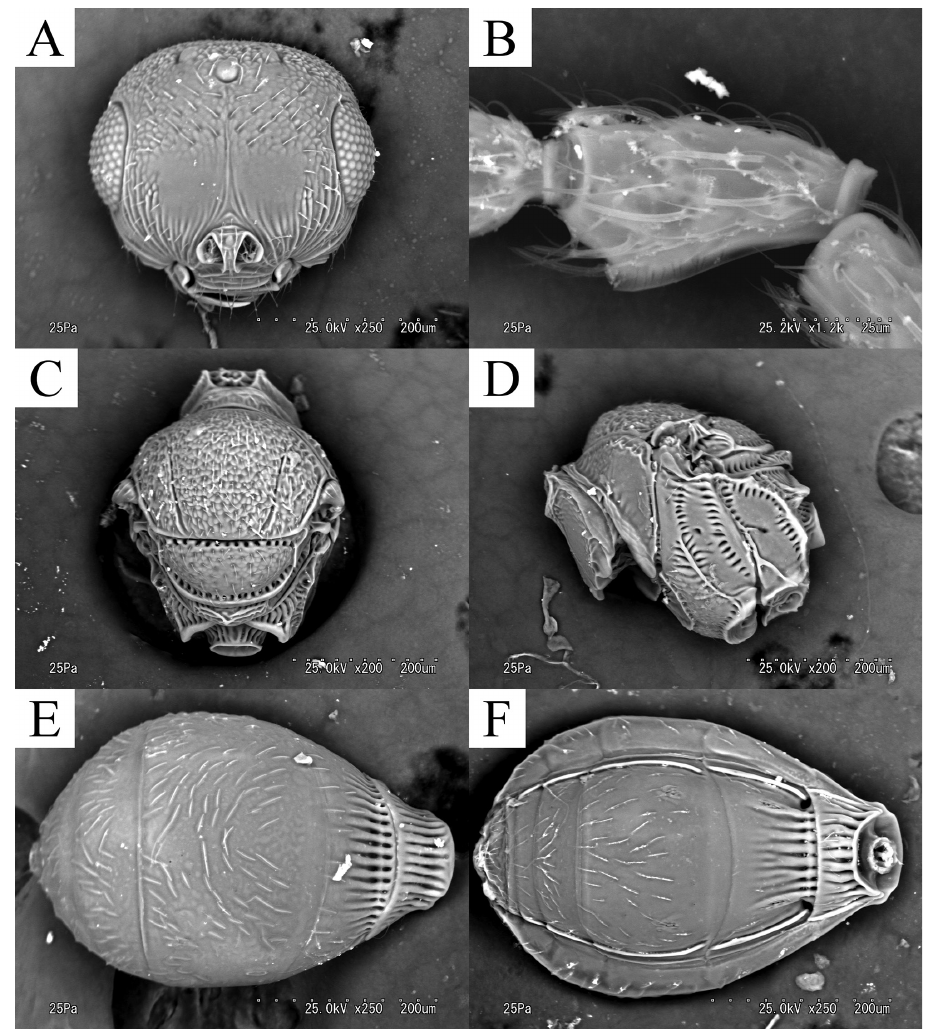
Figure 6. Trimorus granulatus sp. n., male. A head, frontal view B A5, lateral view C mesosoma, dorsal view D mesosoma, lateral view E metasoma, dorsal view F metasoma, ventral view.